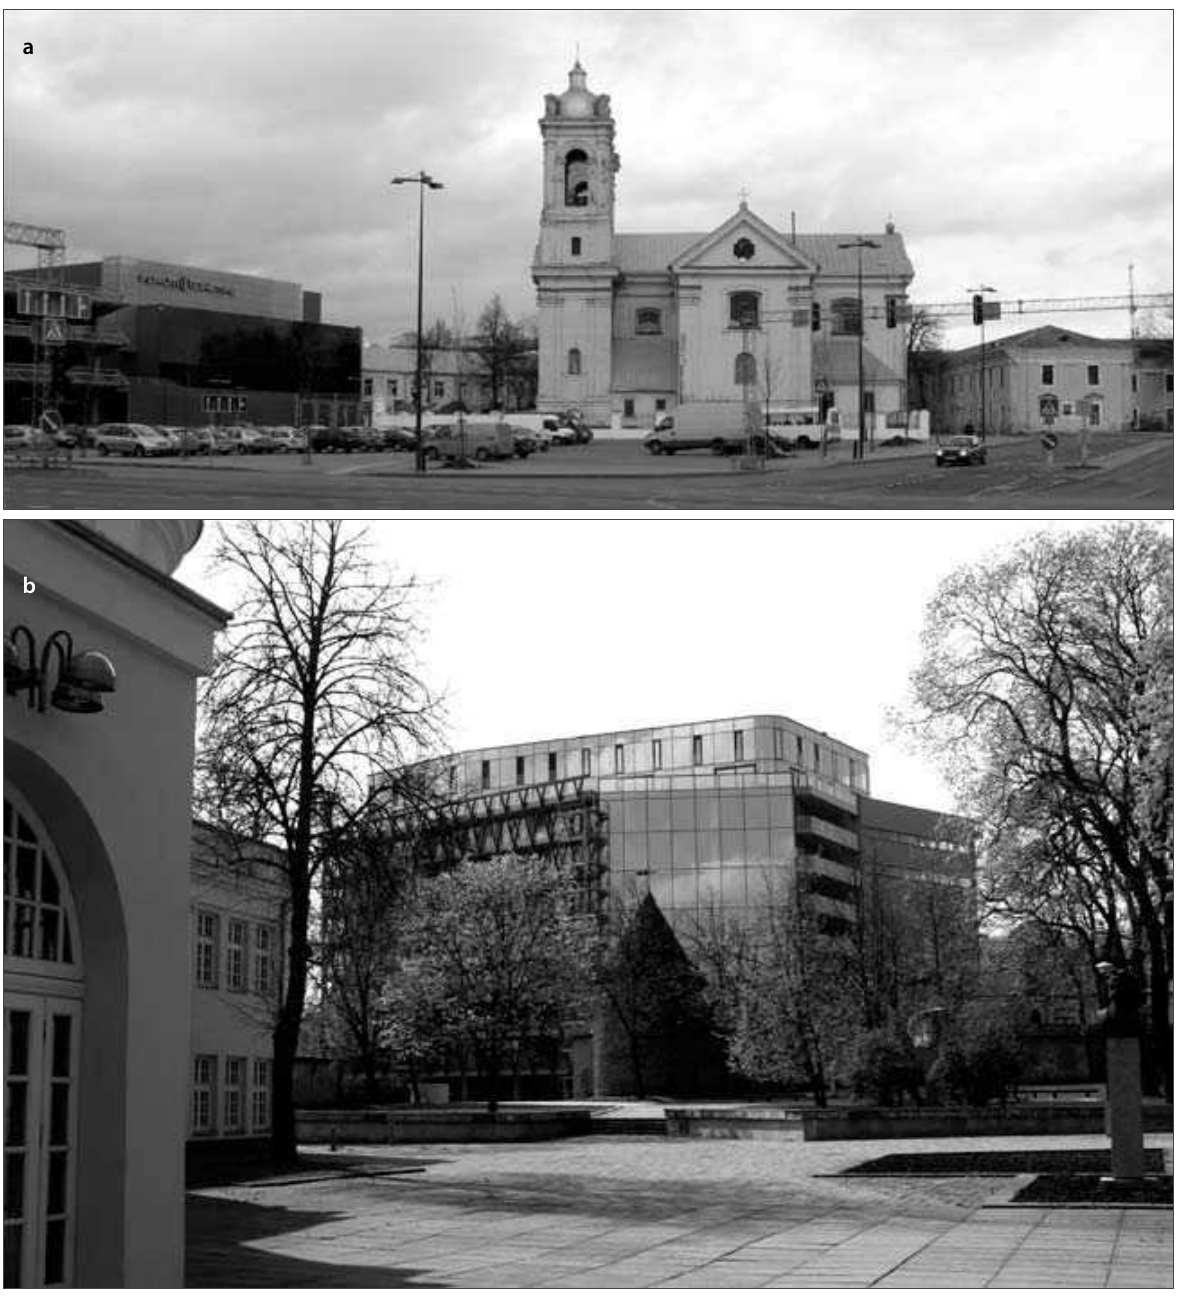
Fig. 1. Contemporary architecture in historic environment of kaunas city (a – photograph by I. Gražulevičiūtė-Vileniškė, b – pho- tograph by J.